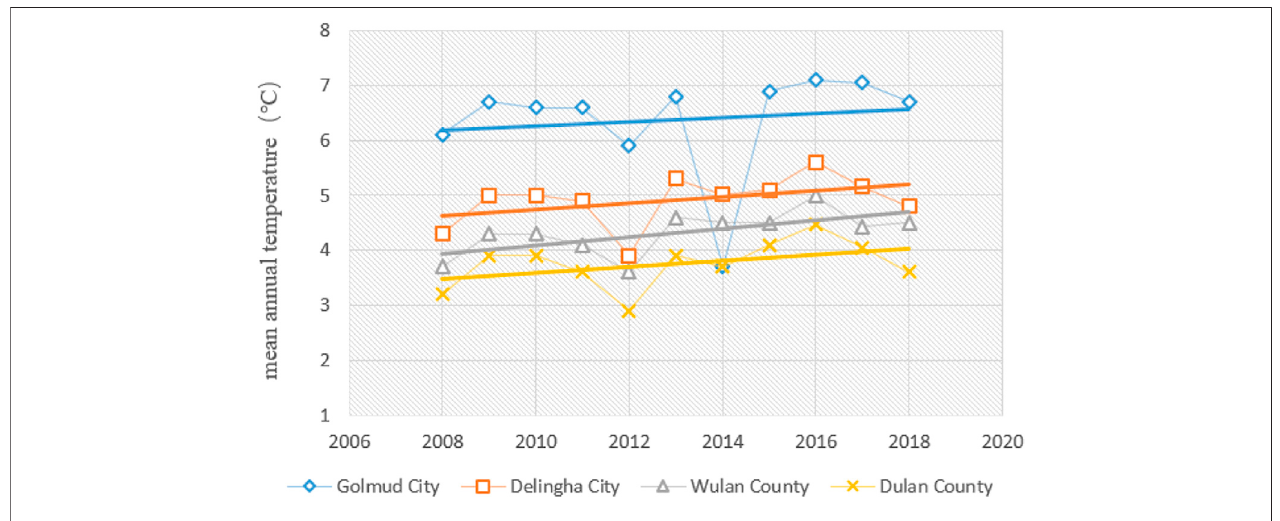
FIGURE 4 | Multi-year mean temperature trend chart.